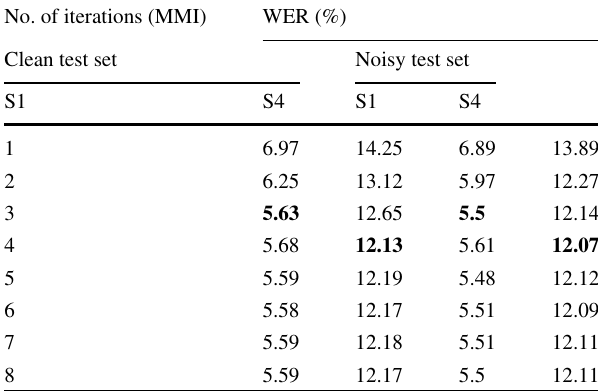
Table 5 WER obtained on varying no of MMI iterations in matched and mismatched systems using clean and noisy test sets No. of iterations (MMI) WER (%) Clean test set Noisy test